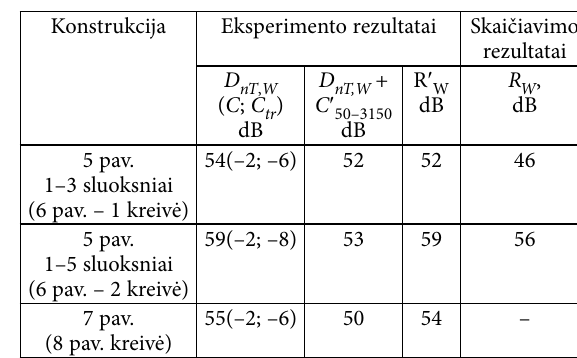
vienparametrių oro garso izoliavimo rodiklių vertės Table 2. The values of single parameter indicators of airborne sound insulation for wall